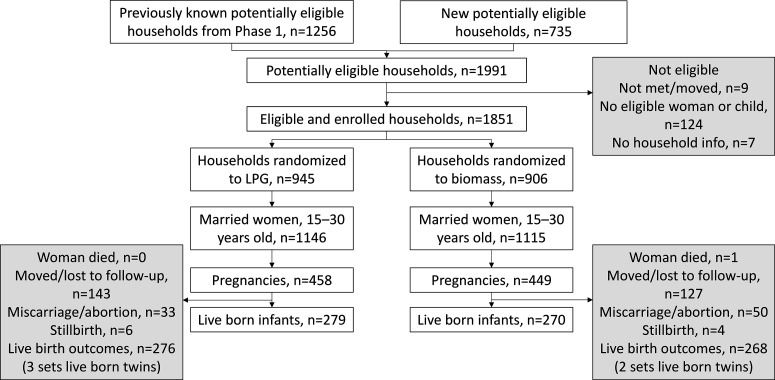
Nepal Cookstove Intervention Trial, Phase 2 CONSORT Diagram